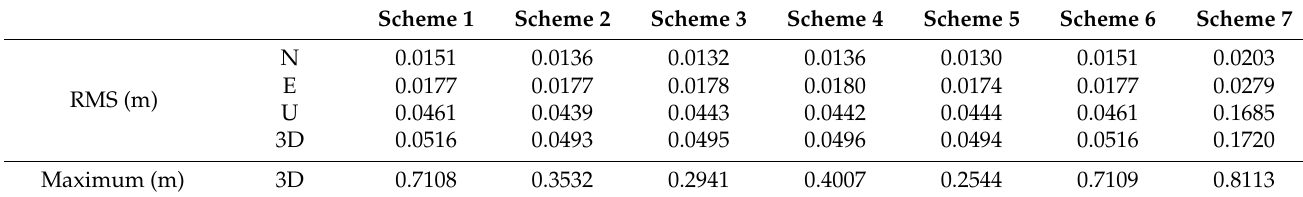
Table 6. The accuracy statistics of position errors of proposed schemes.